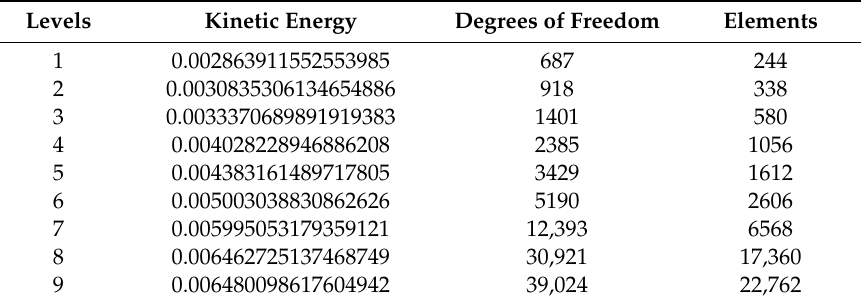
Table 1. Grid convergence for kinetic energy.